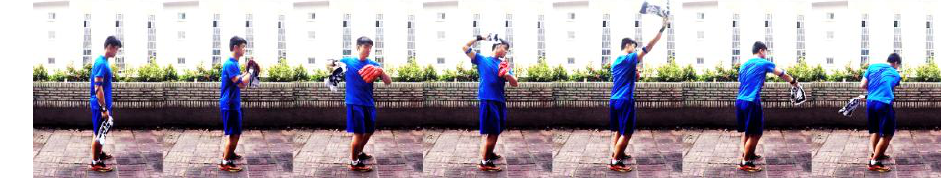
Figure 14. Signal measurement in continuous throwing action .